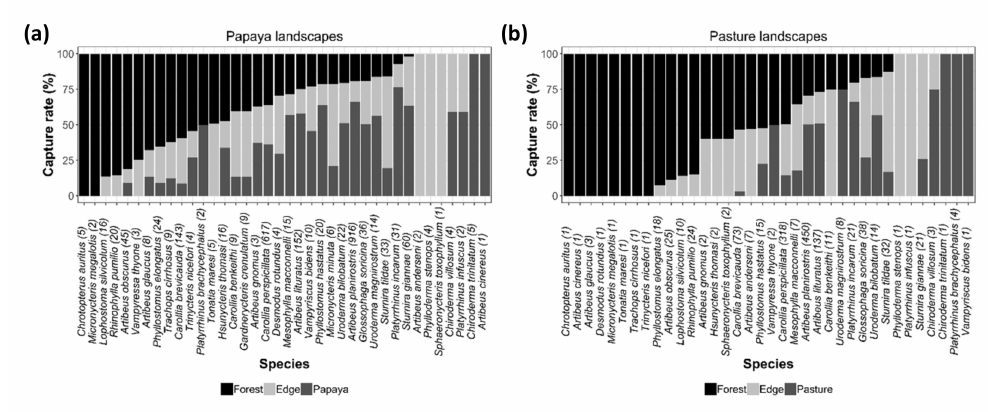
Figure 6. Percentage of captures rate for species that registered more than 5% of overall occurrence. Species are arranged from higher percentage in forest interior to only found in agricultural land. ( a ) Papaya plantations site category; ( b ) cattle pasture site category.